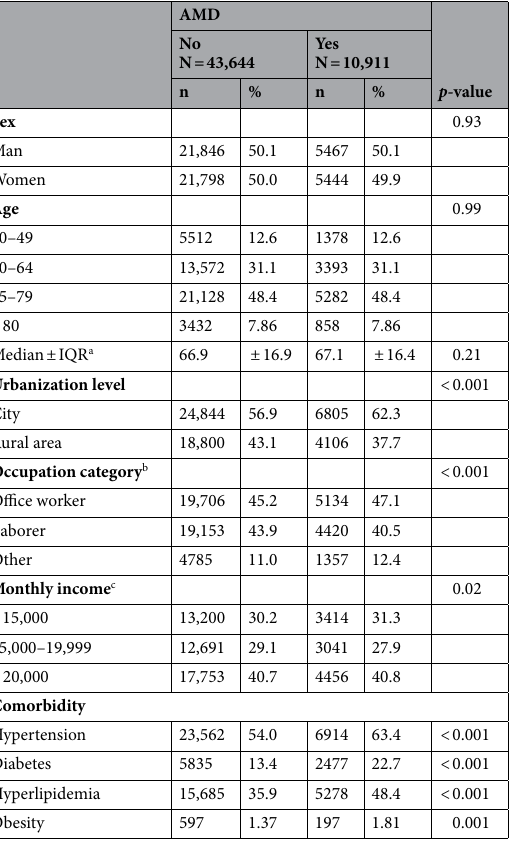
Table 2. Baseline characteristics between AMD group and non-AMD group. AMD age-related macular degeneration, IQR interquartile range. a Mann–Whitney U test. b Other occupation included